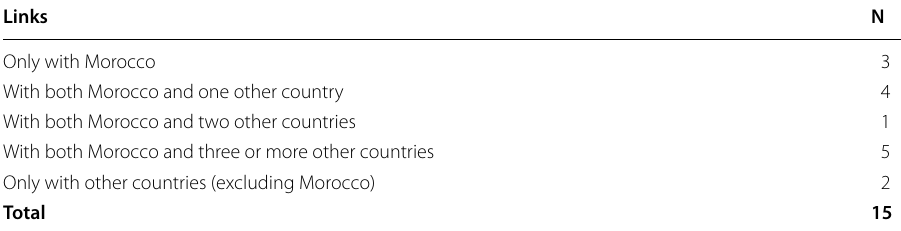
Table 1 Countries respondents have business links with (next to/apart from their current country of residence, i.e. the Netherlands) Links N Only with Morocco 3 With both Morocco and one other country 4 With both Morocco and two other countries 1 With both Morocco and three or more other countries 5 Only with other countries (excluding Morocco) 2 Total